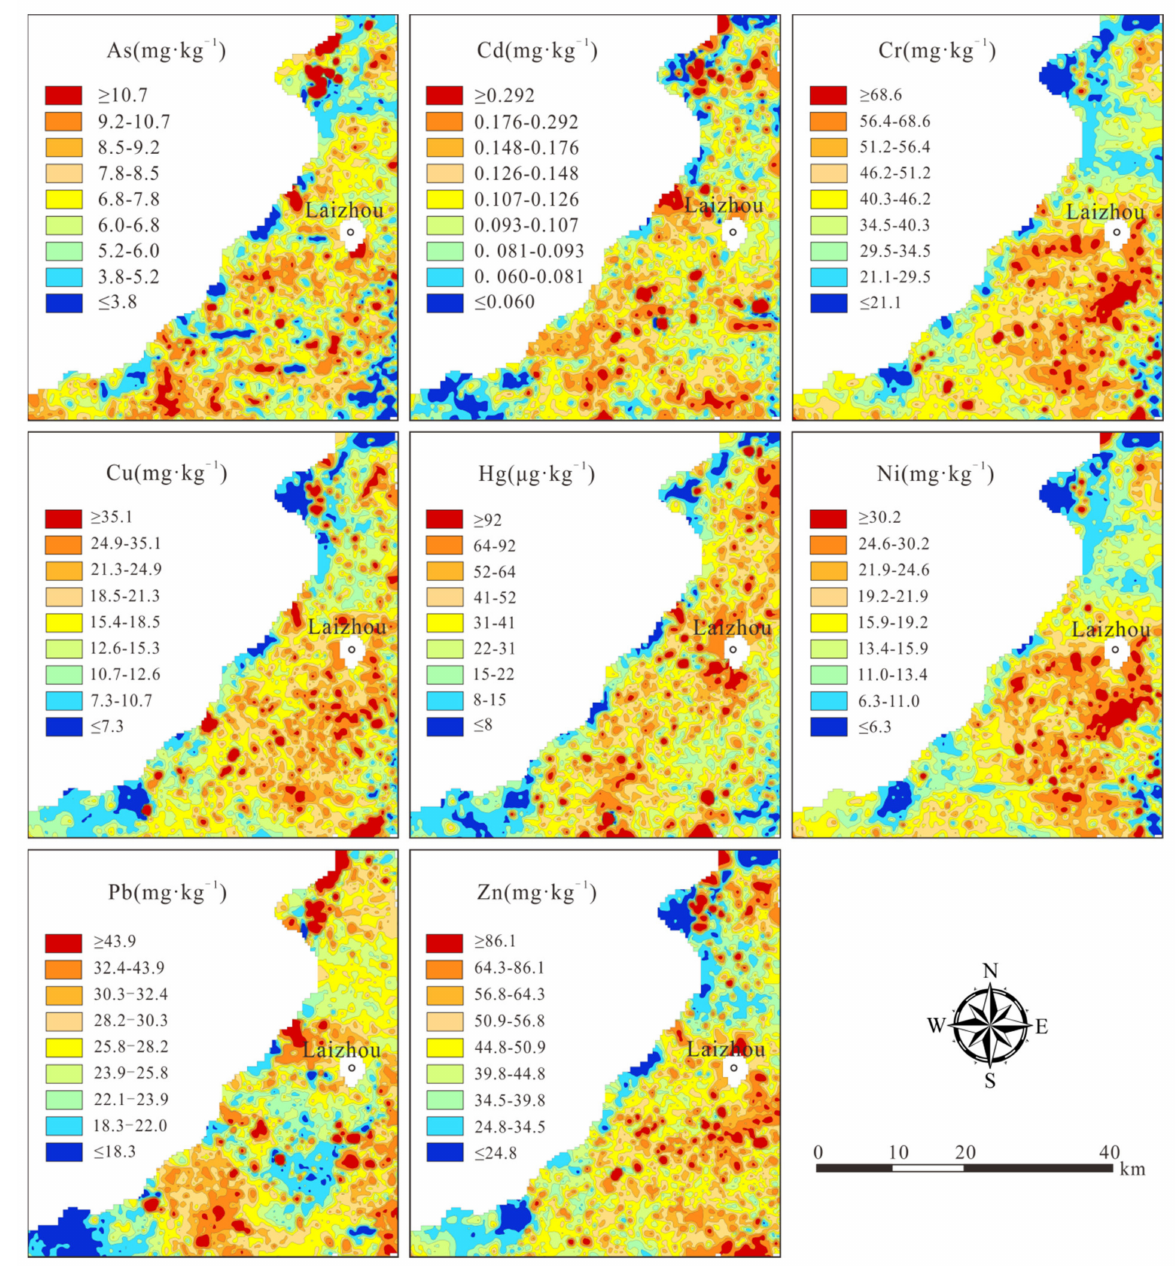
Figure 3. Horizontal distribution of heavy metal (As, Cd, Cr, Cu, Hg, Ni, Pb, Zn) in the study